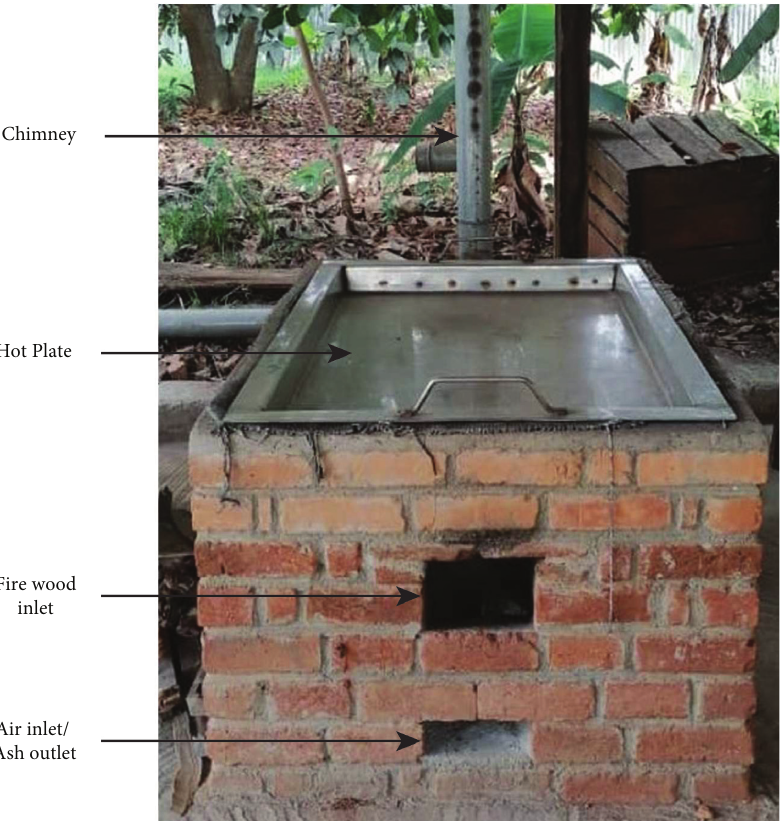
Figure 1: Hot plate roaster.